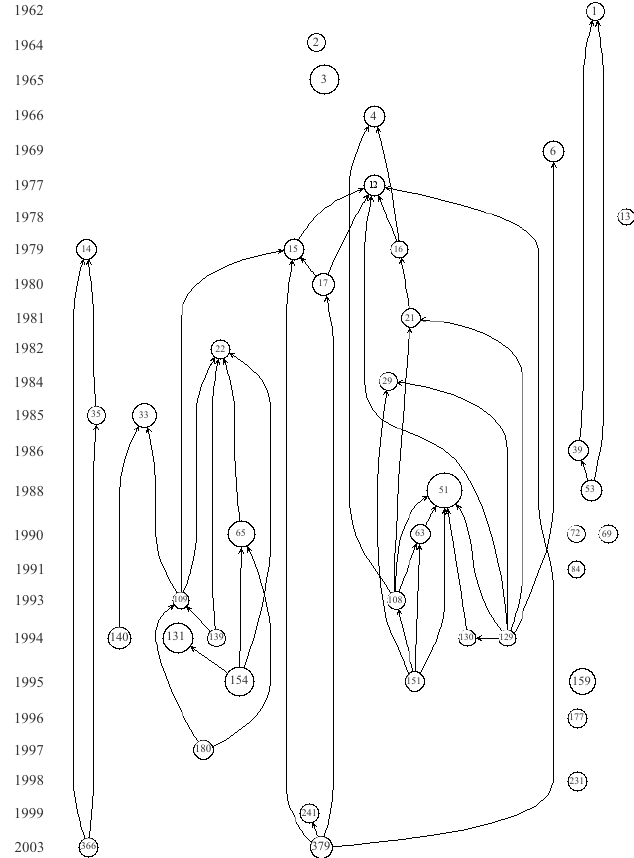
Fig. 2. Historiograph of the 40 most highly-cited publications in the local database Source : own calculation based on the local